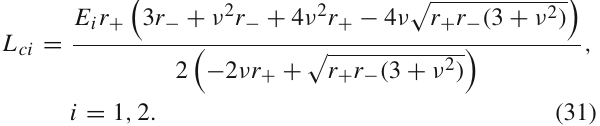
( r + ) at the horizon as a CM